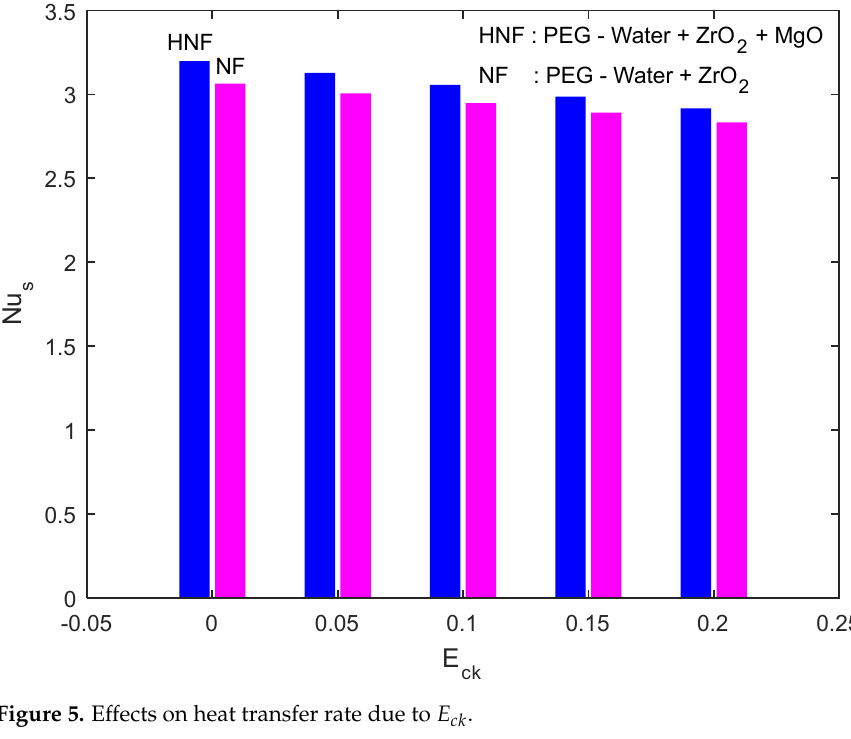
Figure 5. Effects on heat transfer rate due to E ck .